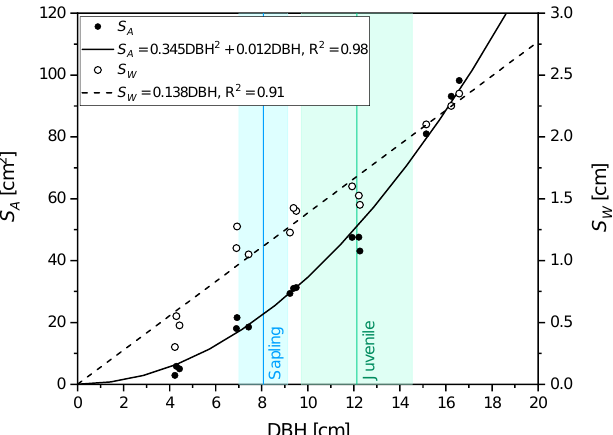
Figure 2. Allometric relationships between diameter at breast height (DBH) and sapwood area ( S A ), as well as sapwood width ( S W ) from 15 Abies balsamea trees located outside the measurement plots. Vertical green and blue lines are the average DBH of trees that were selected for sap flow measurements in Juvenile and Sapling site, respectively, whereas shaded areas represent standard deviations. Intercepts for linear and polynomial fits were forced to